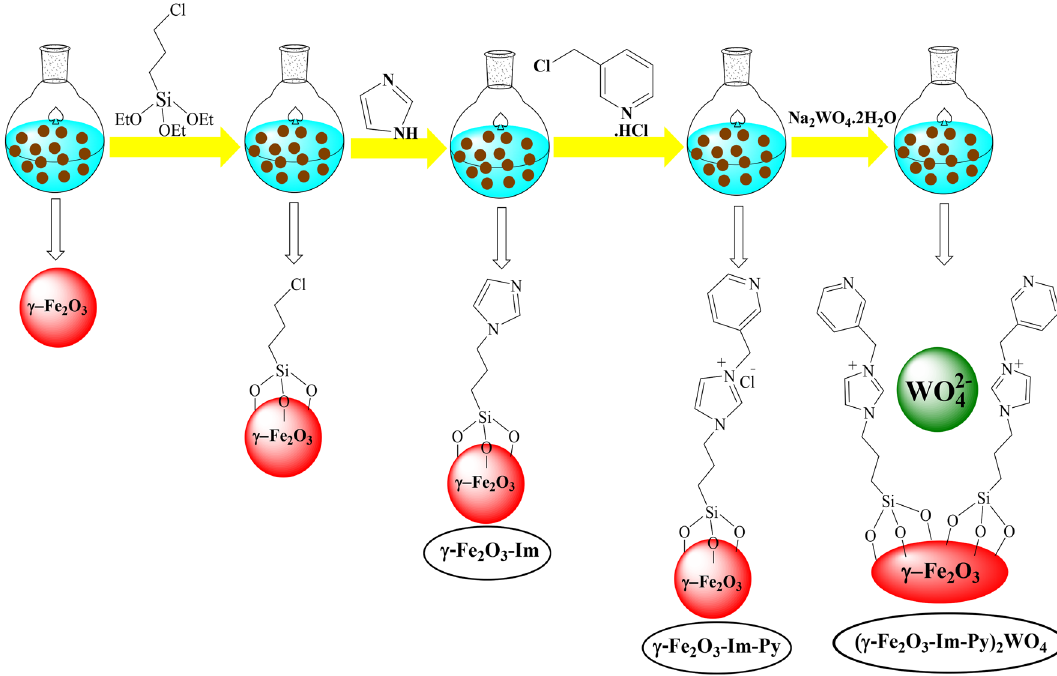
Figure 1. Synthesis of multifunctional (γ-Fe 2 O 3 -Im-Py) 2 WO 4